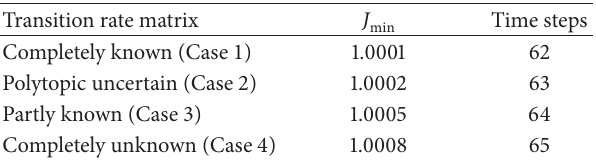
Table 2: Computation results for four different full-order FD filters cases.